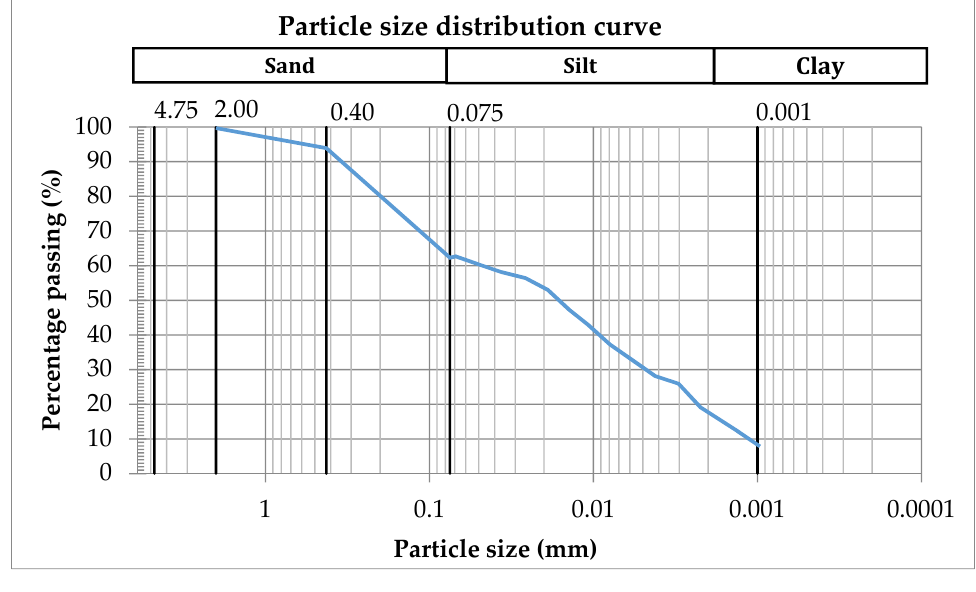
Figure 2. Particle Size Distribution Curve.